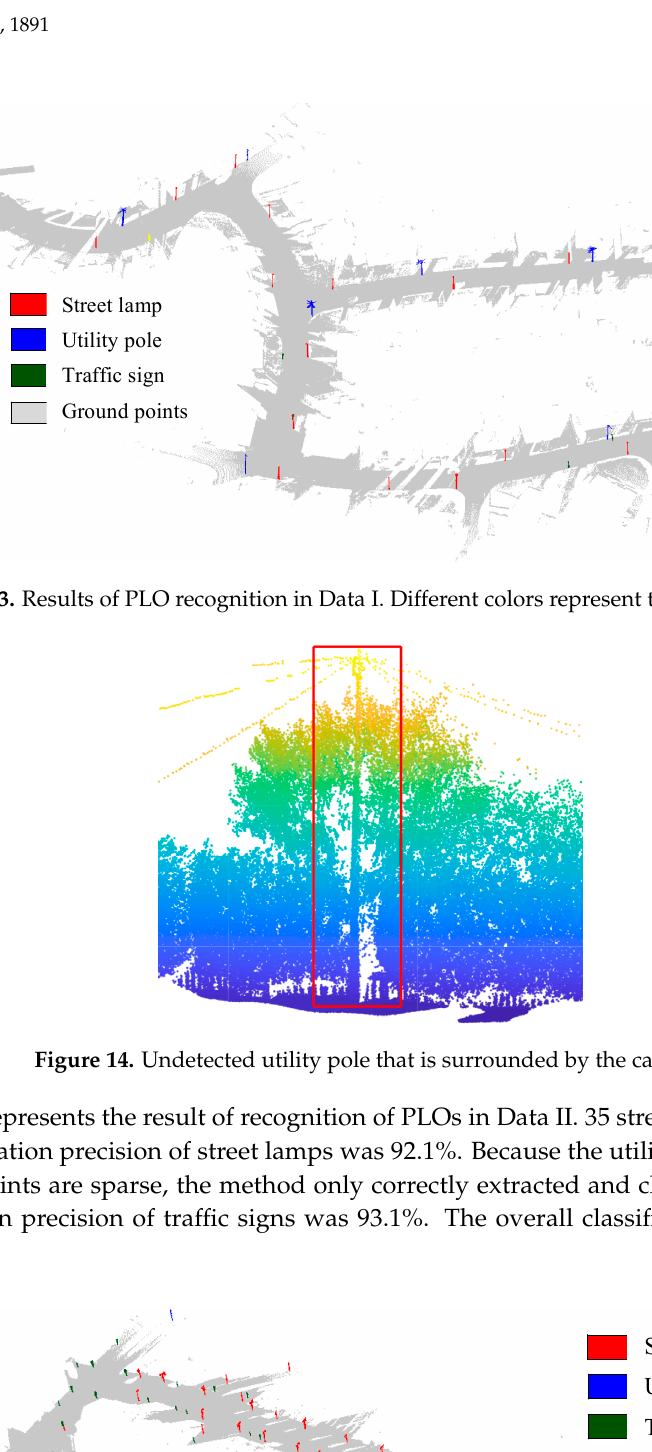
Figure 16. Undetected street lamp due to high crown and low vegetation.